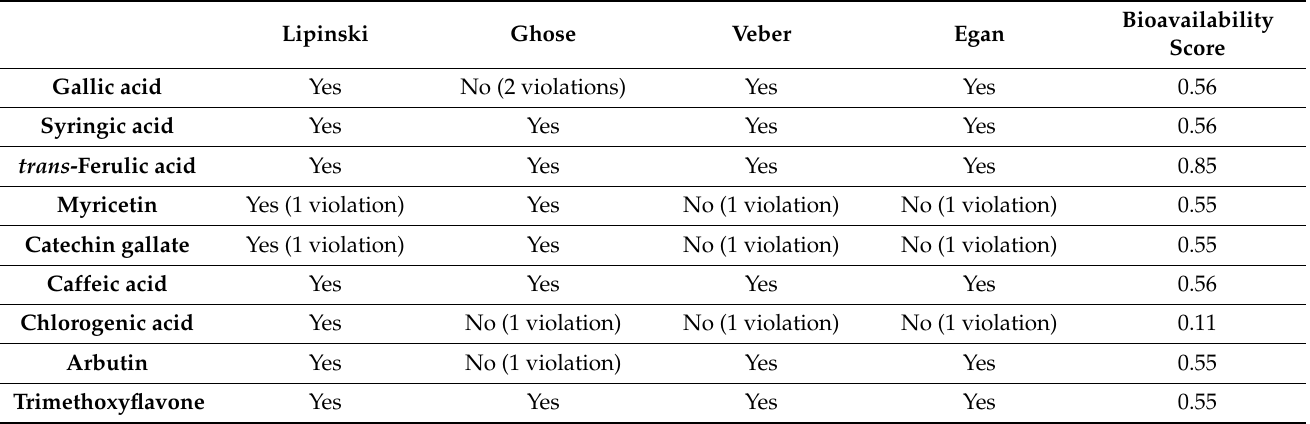
Table 2. Drug likeness and bioavailability score in in silico prediction of AHEE. Lipinski Ghose Veber Egan